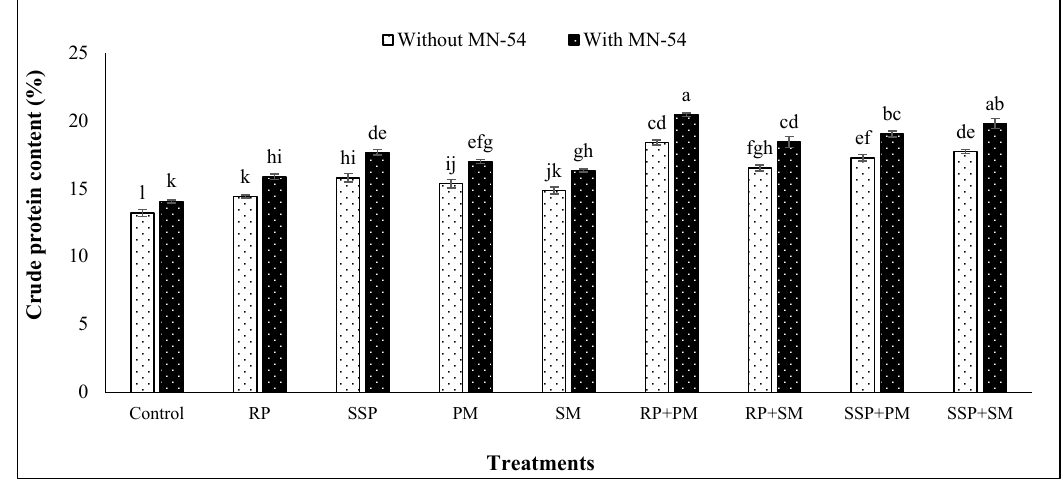
Figure 2. Effect of phosphorus fertilizers, organic manures, and Bacillus sp. MN-54 addition on crude protein content of chickpea measured at 120 d after sowing. Column and error bars represent means and standard errors of triplicate values, respectively. Means having different letters differ significantly according to LSD test at p ≤ 0.05. (MN-54, Bacillus sp. MN-54; RP, rock phosphate; SSP, single super phosphate; PM, processed manure; SM, simple manure).